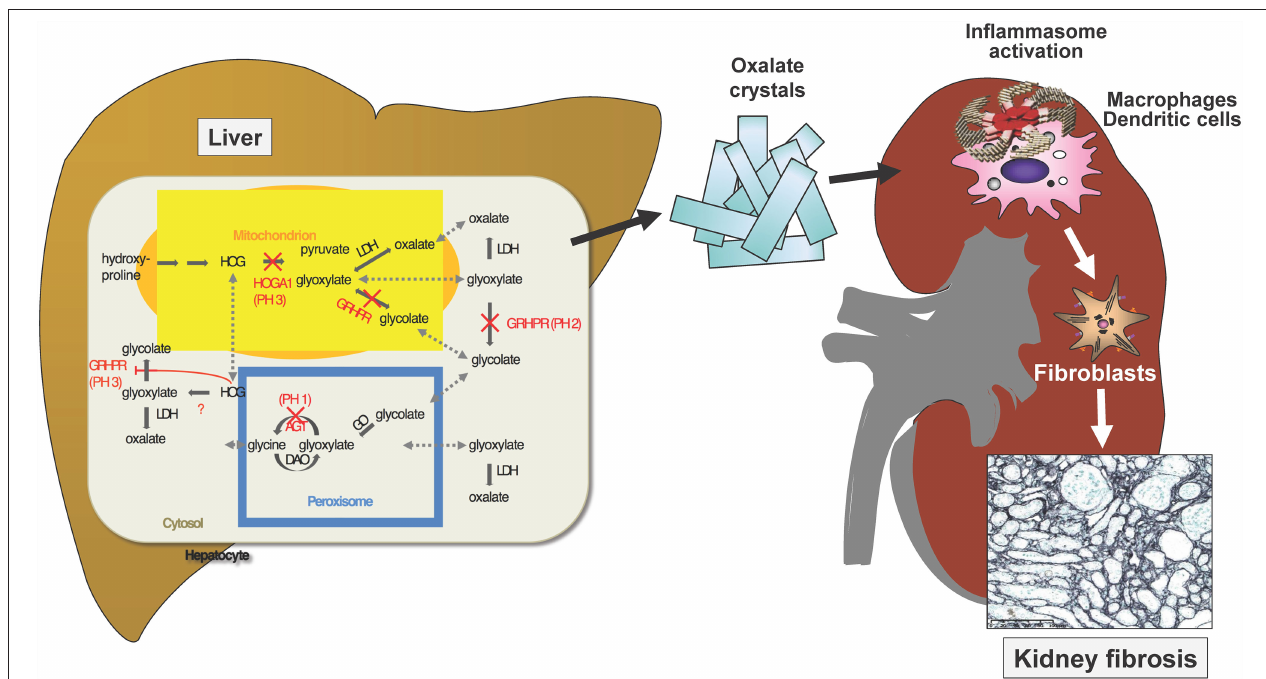
FIGURE 4 | Three known gene defects in hepatocytes cause oxalate accumulation in primary Hyperoxaluria I-III. Ca-Oxalate crystals precipitate in the kidney where water gets reabsorbed and the solubility coefficient of this salt is exceeded. The crystals activate the inflammasome in renal macrophages and dendritic cells, which stimulate interstitial fibroblasts to deposits collagen, resulting in kidney